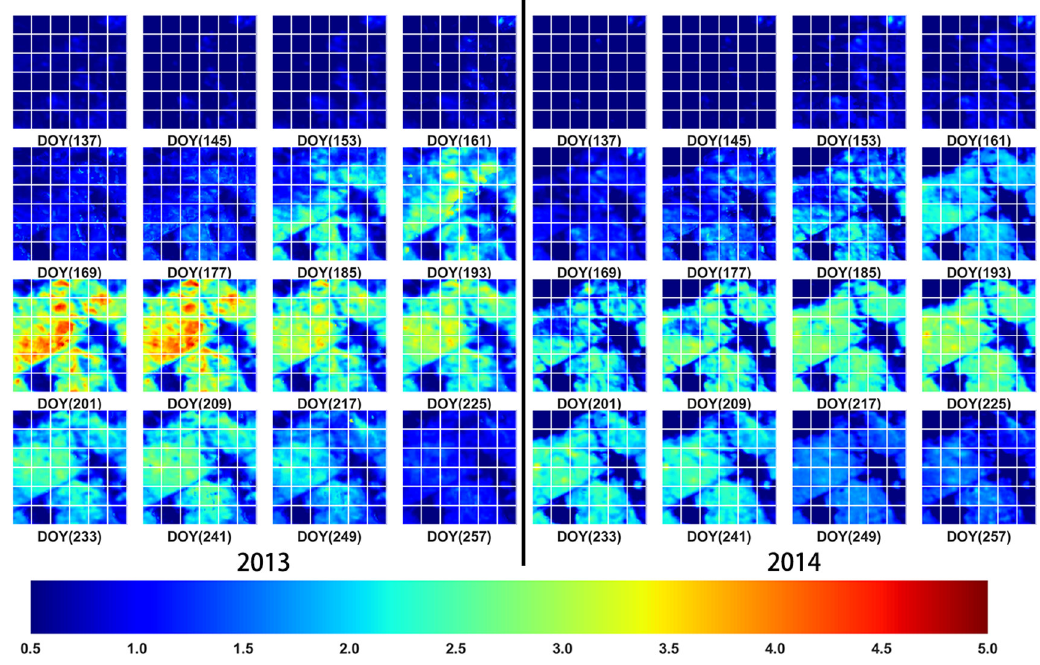
Figure 9. Spatiotemporal LAI maps of the Huailai area in 2013 and 2014 (100 × 100 pixels, 30 m spatial resolution) predicted by the NARX model.